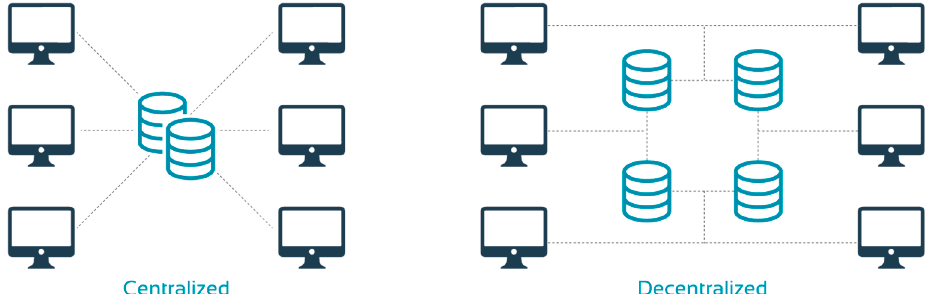
Figure 4. Centralized versus decentralized data management.